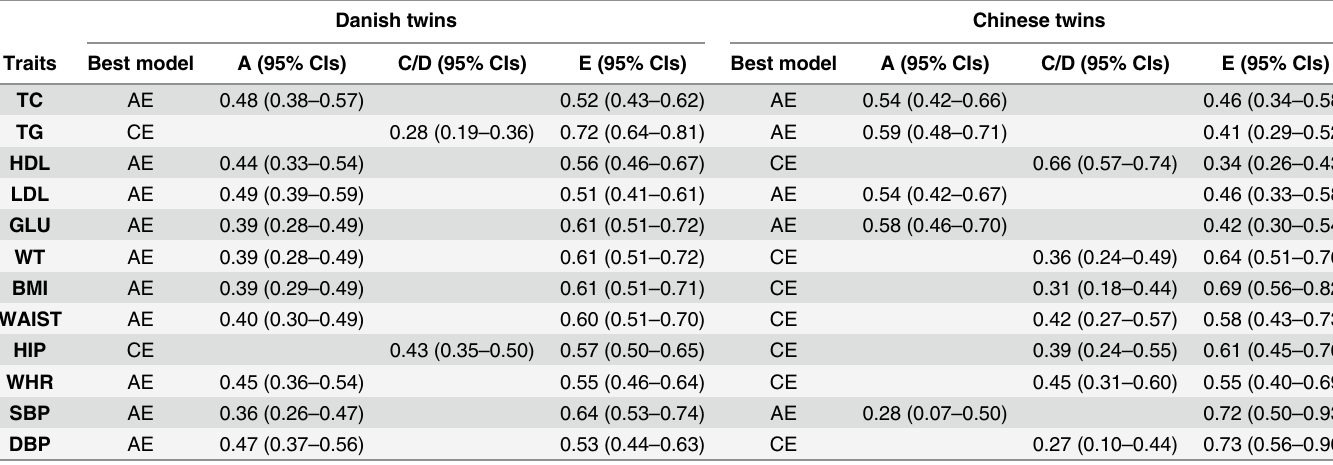
Table 5. Parameter estimates in best fitting models in the Danish and Chinese twins.